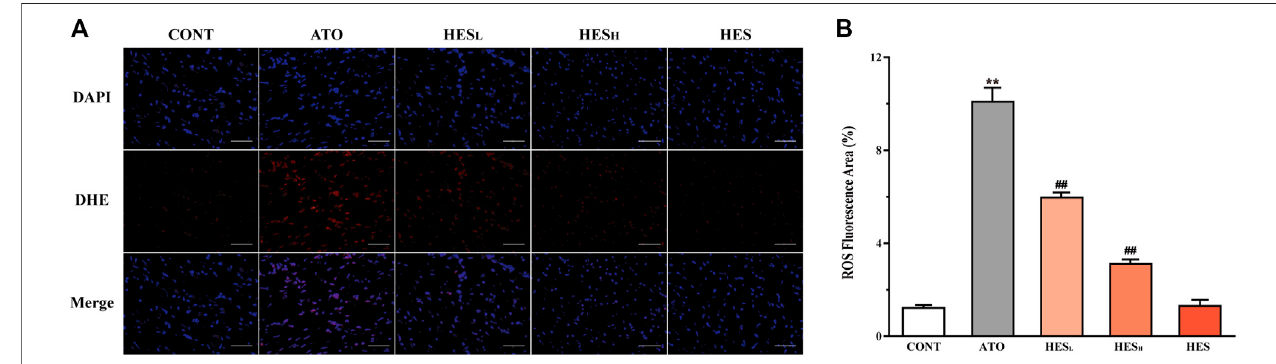
FIGURE4| ChangesinROSexpressionbetweenATOgroupandHEStreatmentgroups. (A) DetectedROSexpressioninmyocardialtissuewithDHEprobe,scale bar (cid:1) 50 μ m. (B) values are expressed as mean ± SD. ** p < 0.01, compared with CONT group, ## p < 0.01, compared with ATO group.